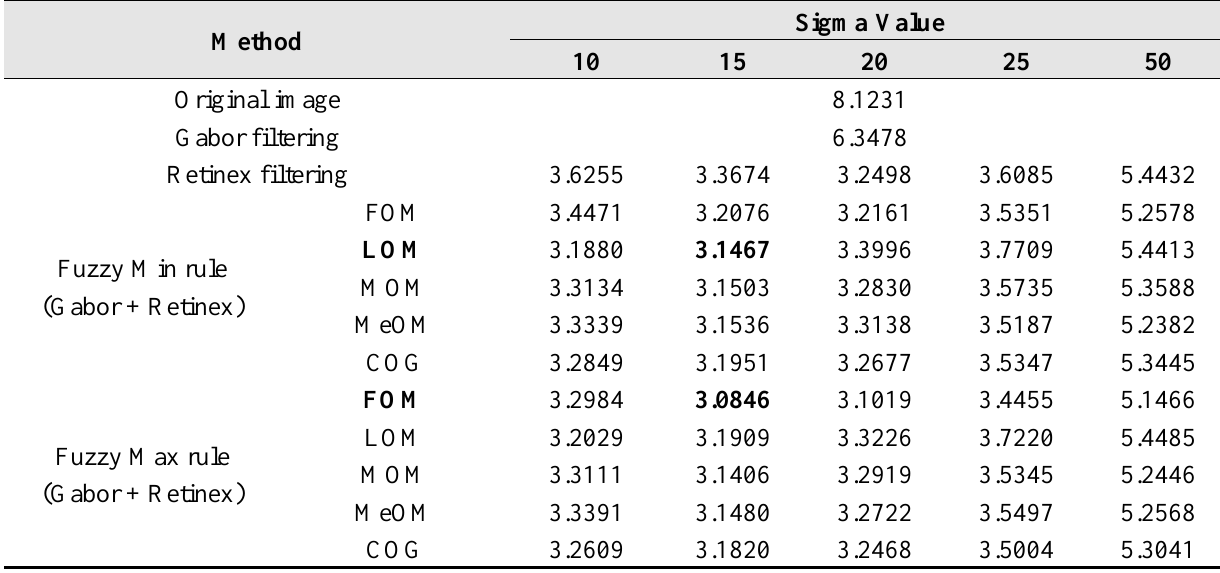
Table 7. Recognition accuracy of the proposed method with Gabor filtering and Retinex filtering using various sigma values and a LBP operator in terms of the EER for images from database II (unit: %).